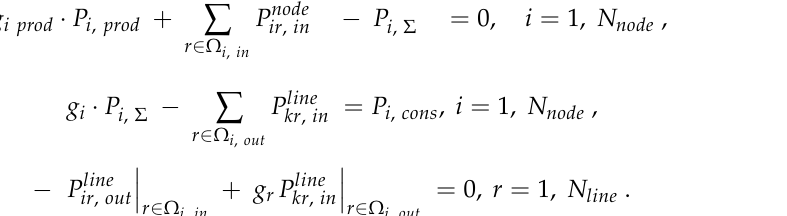
Figure 2. The products of network node [64], (p. 210).